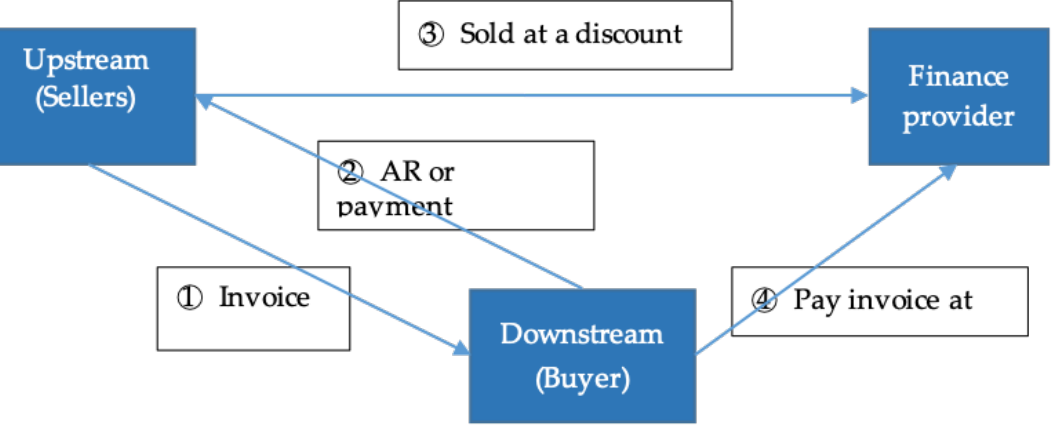
Figure 6. Accounts